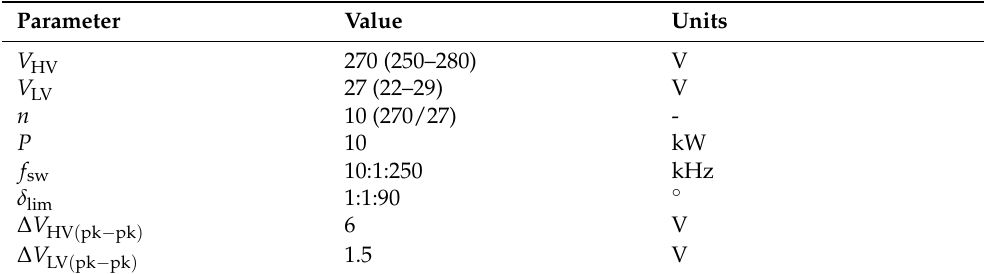
Figure 3. Resulting decoupling inductances versus the switching frequency and δ lim . Table 3. Design